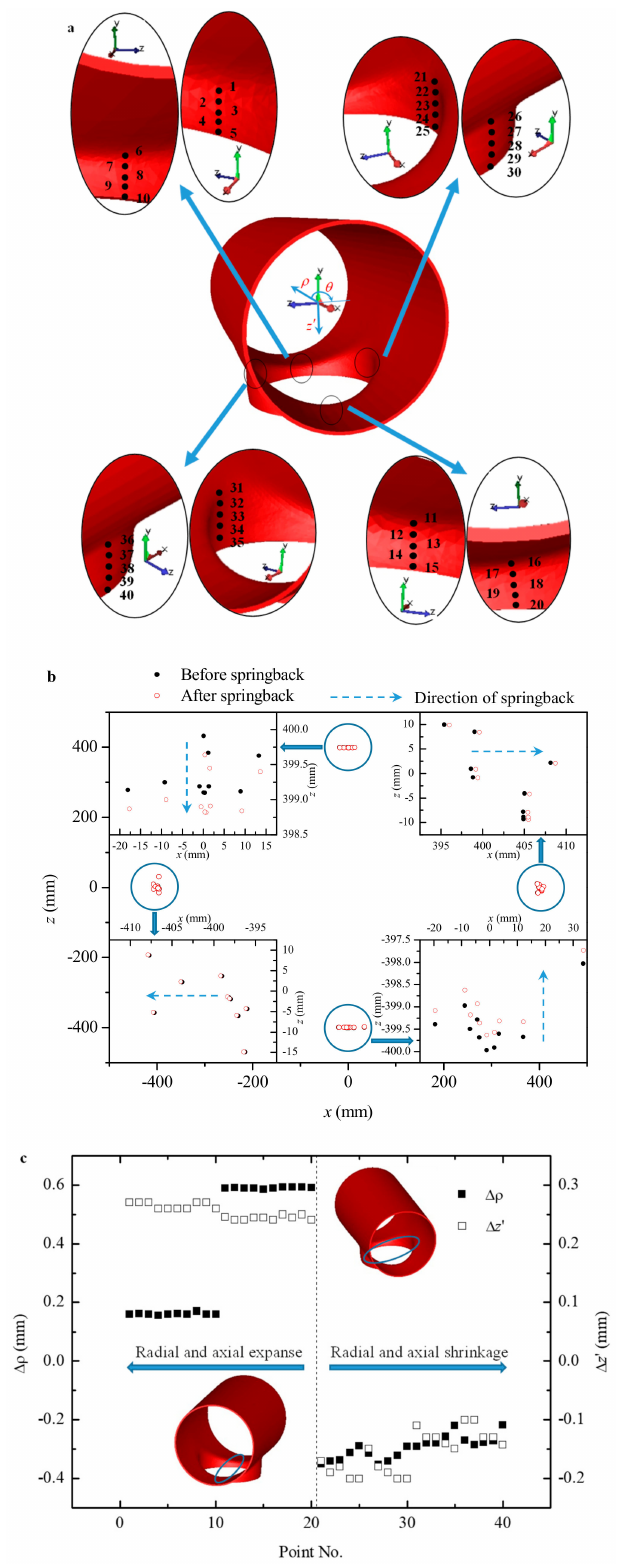
Figure 27. Springback of chosen points: ( a ) positions of points; ( b ) xz projection of chosen points; ( c ) quantitative calculation of